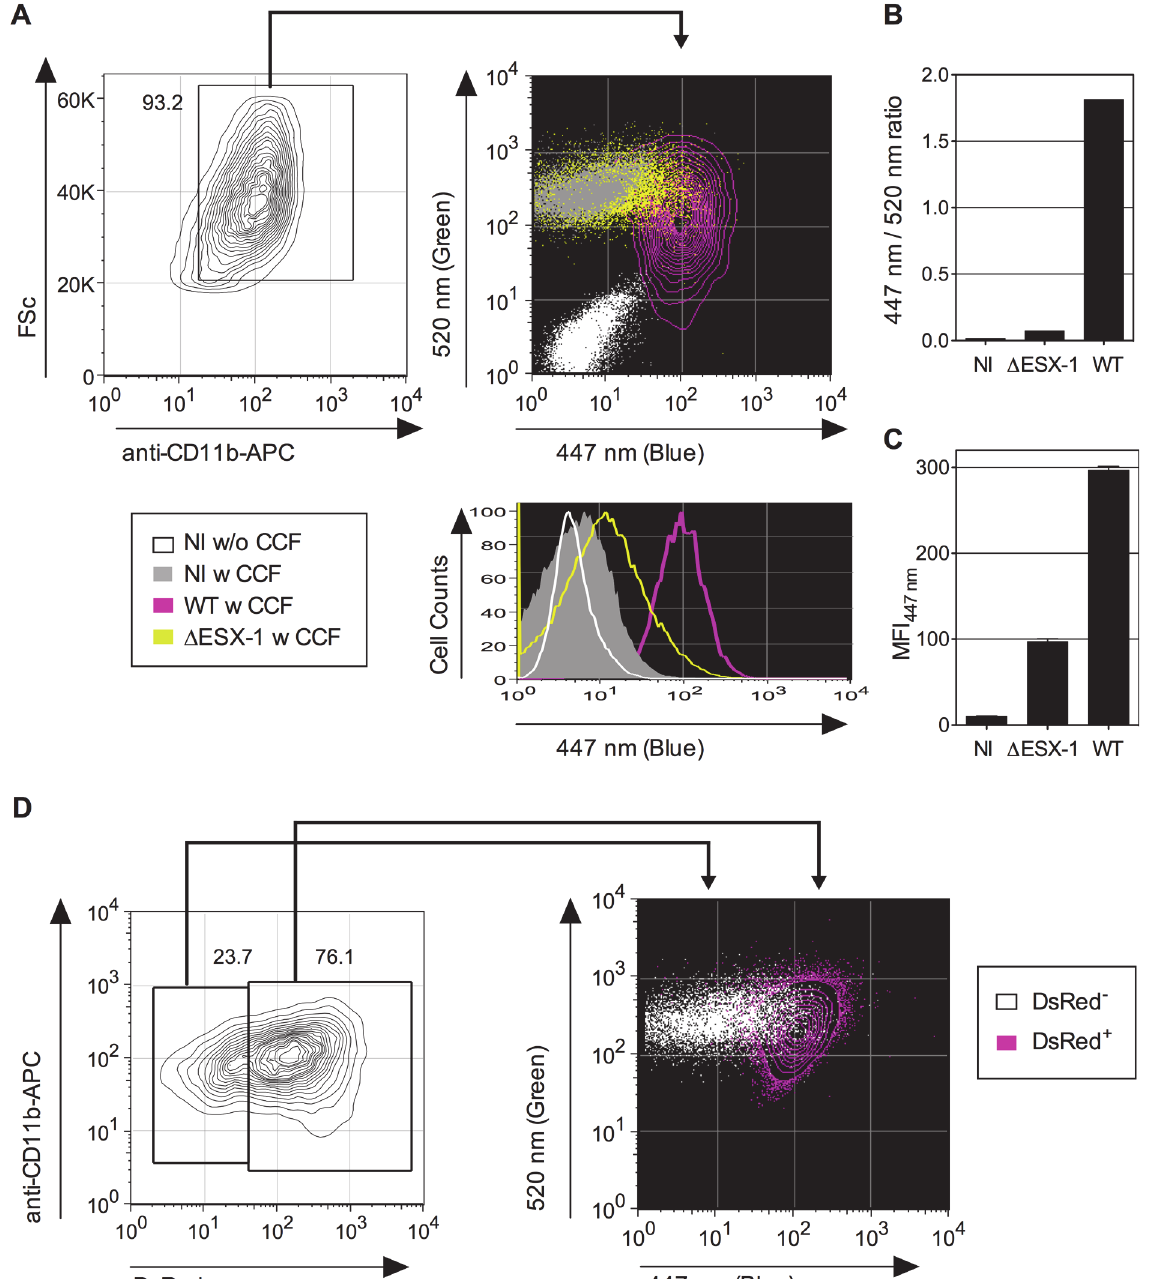
Fig 1. Detection of Mtb -mediated phagosome disruption by flow cytometry. (A) Phagosomal rupture detected by CCF-4 FRET-based flow cytometry. Differentiated THP-1 cells were infected with Mtb , WT or Δ ESX-1 strain (MOI = 1); NI = not infected. At 4 dpi, cells were successively stained with CCF-4 and anti-CD11b mAb, fixed, and their green (520 nm) vs . blue (447 nm) fluorescent signals were analyzed after gating on CD11b + cells. Results are depicted as signal overlays of different groups as dot or contour blots. (B-C) Shown are ratios of MFI 447 nm / MFI 520 nm (B) and blue MFI 447 nm (C), calculated as described in Materials and Methods. (D) Differentiated THP-1 cells were infected with DsRed-expressing Mtb H37Rv strain (MOI = 0.3). At 4 dpi, cells were stained as in A. The cells having phagocytosed DsRed- Mtb (DsRed + ) were first gated for their red signal and their green vs . blue CCF-4 signals were compared to the cells in the same culture that had not engulfed DsRed- Mtb (DsRed - ). The results are representative of at least 3 independent experiments.